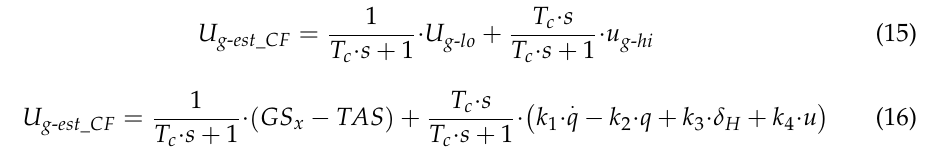
Figure 3. Bode diagram (amplitude and phase) for linear CF. On the basis of dependencies (1), (2), (12)–(14), the complete law of headwind estima- tion (including temporary gusts) can be formulated as (15), and finally, as Equation (16).